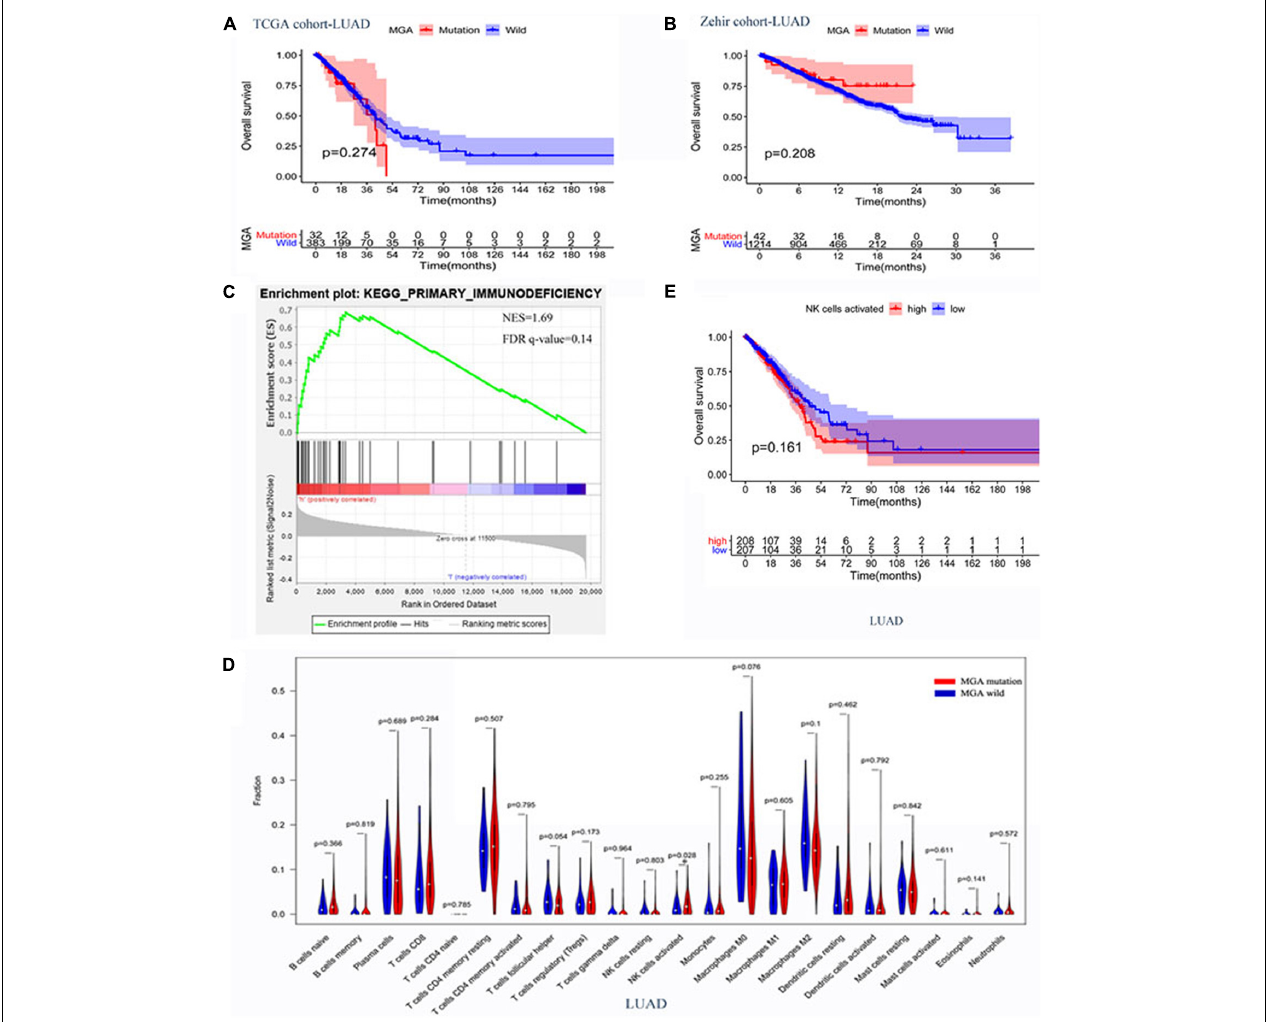
FIGURE 6 | The potential mechanisms of MGA mutation in predicting the outcomes of ICI treatment in LUAD patients. (A,B) Associations of MGA mutation and OS in non-ICI treatment cohorts, TCGA cohorts, and Zehir cohorts. (C) The enrichment in primary immunodeficiency pathway by Gene Set Enrichment Analysis (GSEA) between MGA mutant and wild-type group in TCGA cohorts. (D) Violin plot comparing the TIICs between patients with MGA mutant and wild-type in TCGA cohorts. (E) Kaplan-Meier survival curves comparing OS between the activated NK cells low-infiltrating group and high-infiltrating group in the TCGA cohort. ∗ P < 0.05 indicated statistically significant